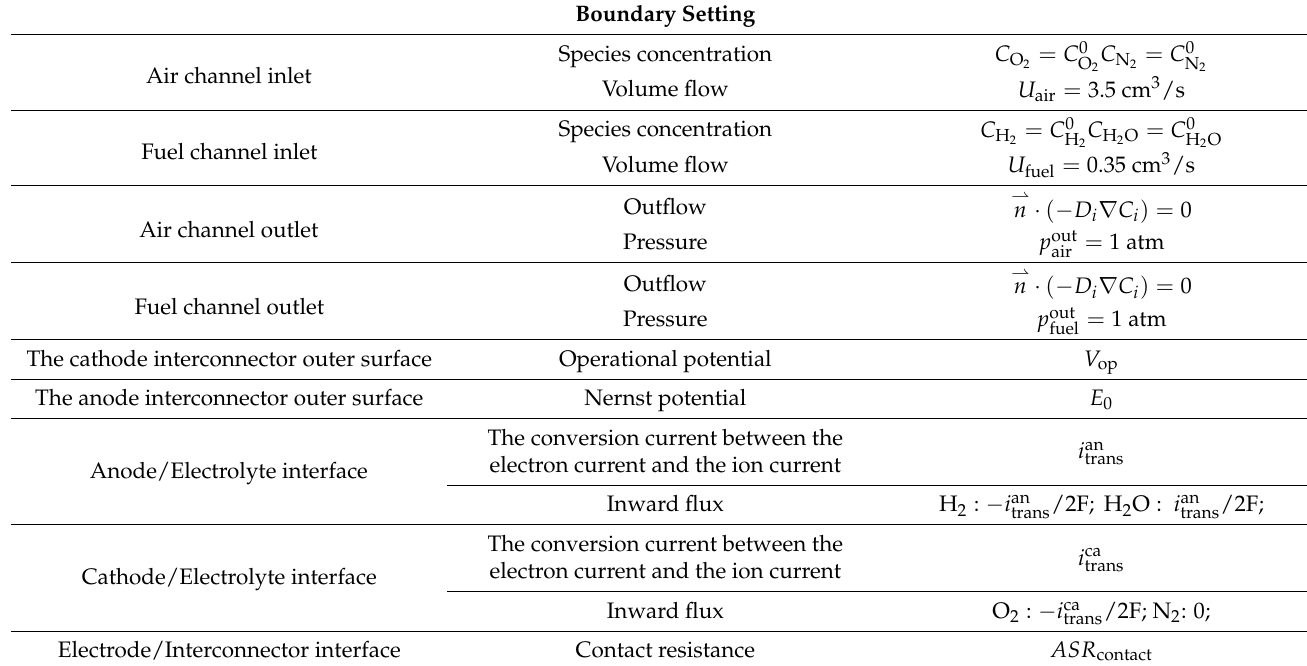
Table 2. Boundary setting.